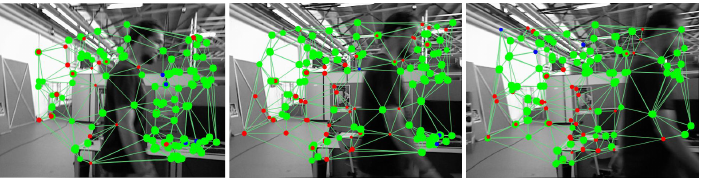
Figure 5. Examples of Delaunay triangulation. The green points are the feature points of R-MPs. The larger the point, the greater the reliability is. The red points are the feature points of U-MPs, and the blue points are the feature points of